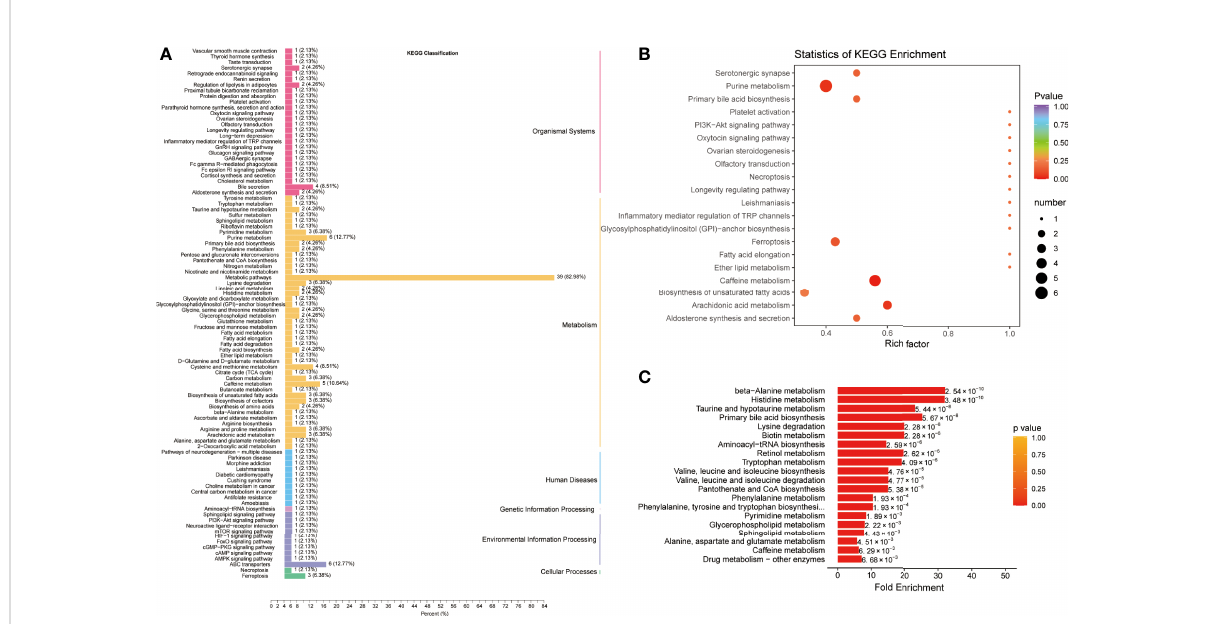
FIGURE 4 Pathway enrichment analysis of differentially expressed metabolites between COVID-19 patients and community-acquired pneumonia. (A) Kyoto Encyclopedia of Genes and Genomes (KEGG) classi fi cation of differentially expressed metabolites between community-acquired pneumonia (CAP) and COVID-19 patients (CP). (B) KEGG pathway enrichment analysis of differentially expressed metabolites. (C) Metabolite Set Enrichment Analysis (MSEA) between CAP and